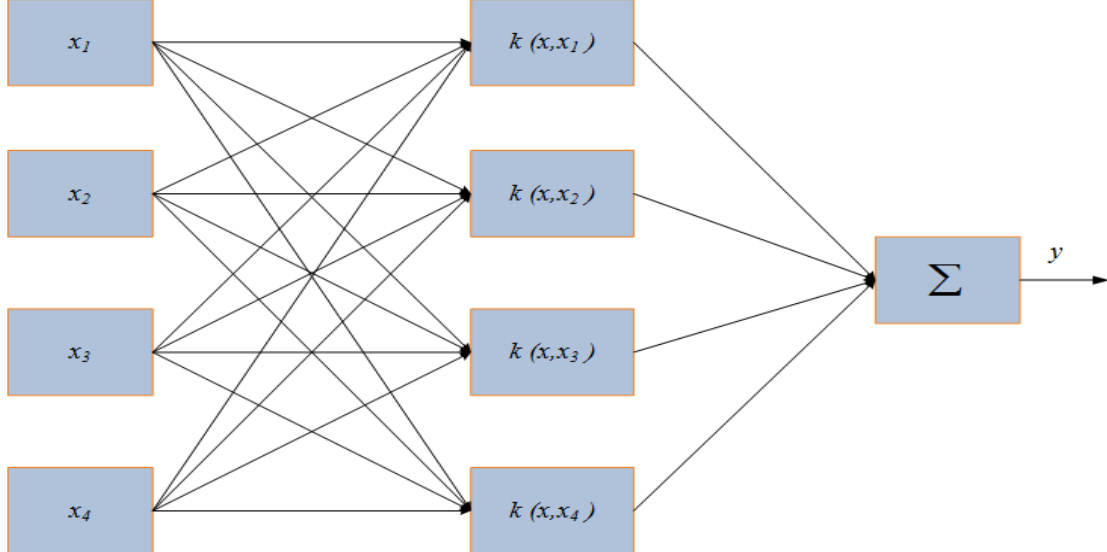
Figure 2. The least square support vector regression (LSSVR) model for wind speed/power prediction.